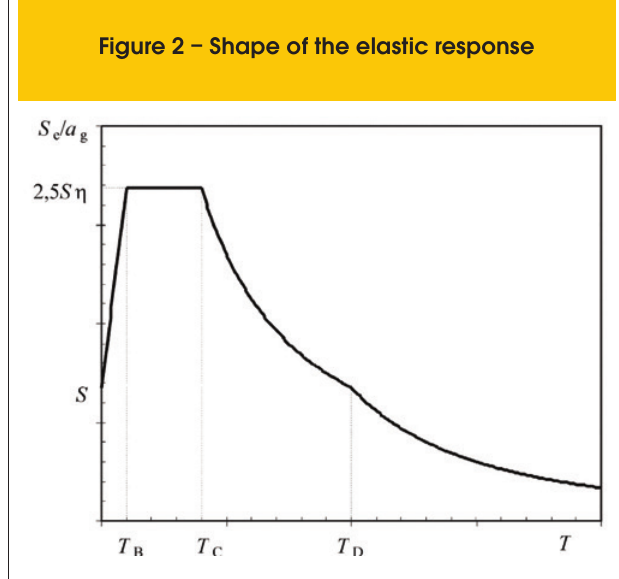
Figure 2 – Shape of the elastic